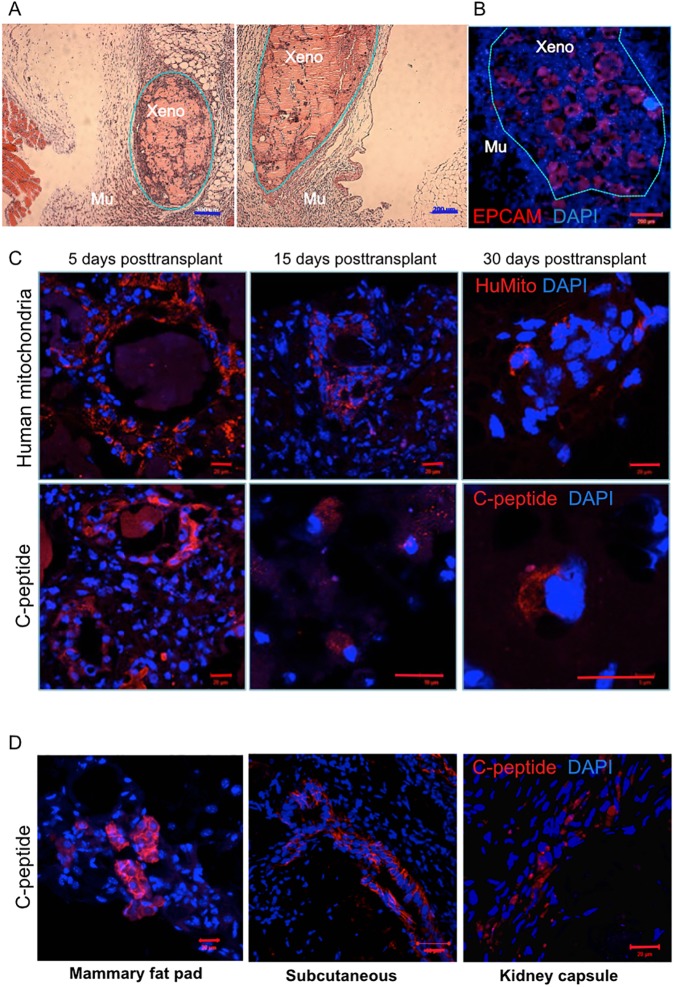
Transplantation of rGBCs into NSG mouse.(A) H&E sections of engrafted rGBCs (Xeno) into the epididymal fat (n = 17) surrounded by mouse tissue (Mu) (scale bar = 200 μm). (B) Immunofluorescent staining of human EPCAM marking the location of rGBCs in the epididymal fat (scale bar = 200 μm). (C) Human mitochondria and C-peptide immunofluorescence of rGBC grafts at three time points after transplantation into the epididymal fat. (D) C-peptide immunofluorescence of rGBC clusters 2 weeks after transplant into mammary fat pad (left) (n = 17), upper back subcutaneous area (middle) (n = 12), and kidney capsule (right) (n = 17) (scale bar = 20 μm).